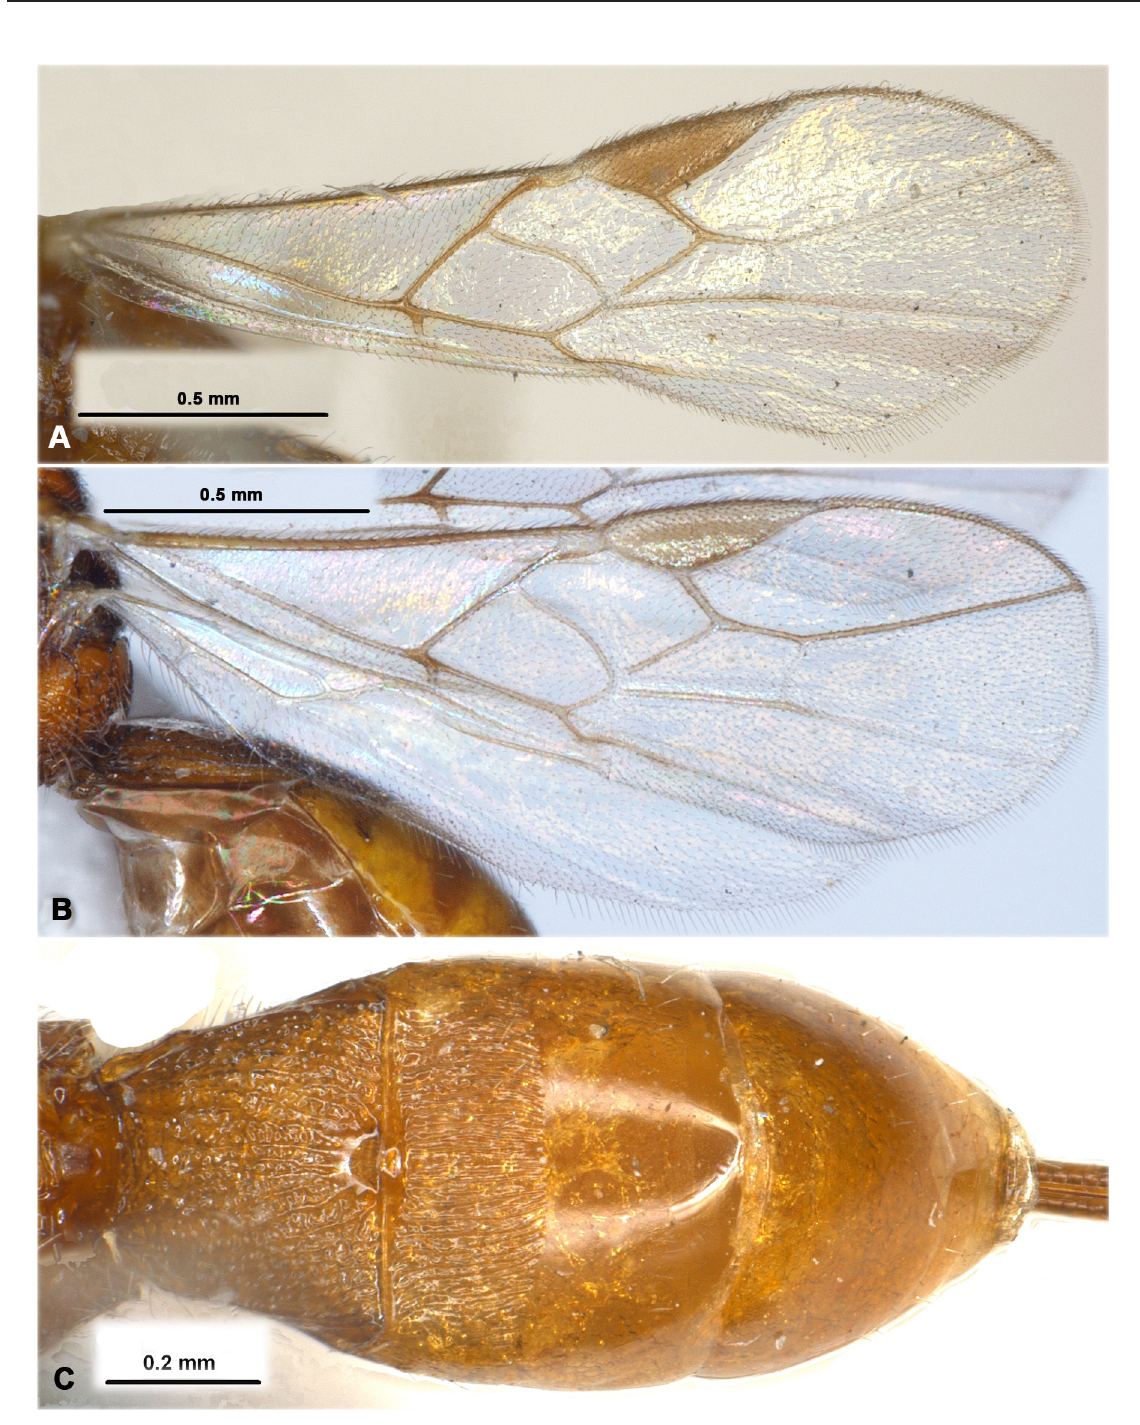
Fig. 35. Parallorhogas testaceus (Szépligeti, 1914). A, C . Holotype, ♀ (MNBG). B . Arabian specimen (RMNH). A . Fore wing. B . Wings. C . Metasoma, dorsal